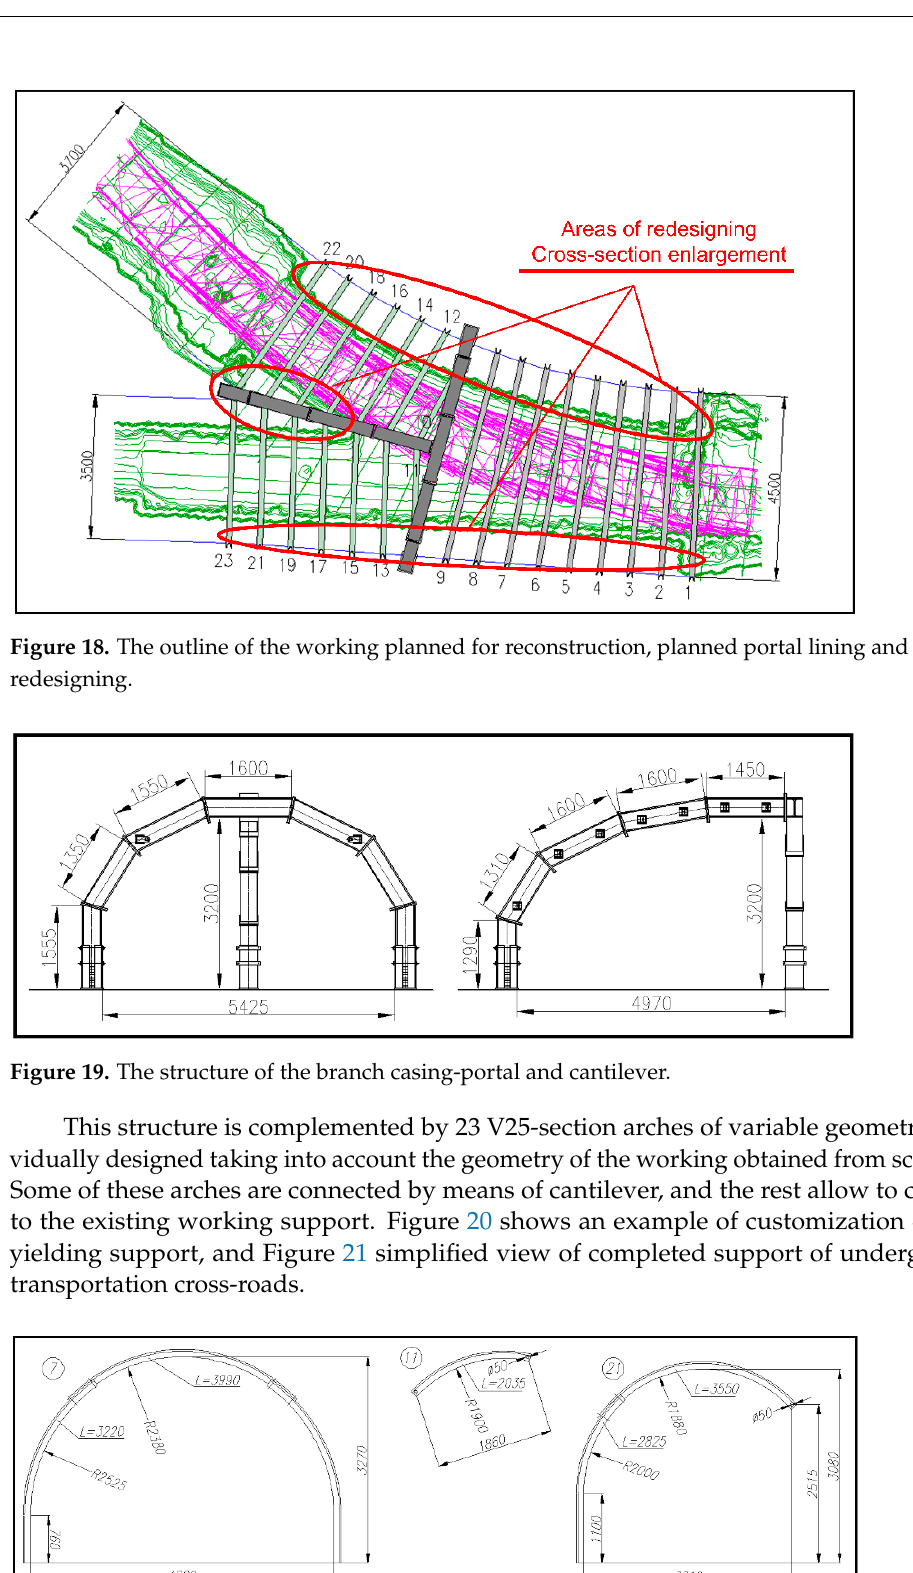
Figure 20. Example of customization of arch yielding support.